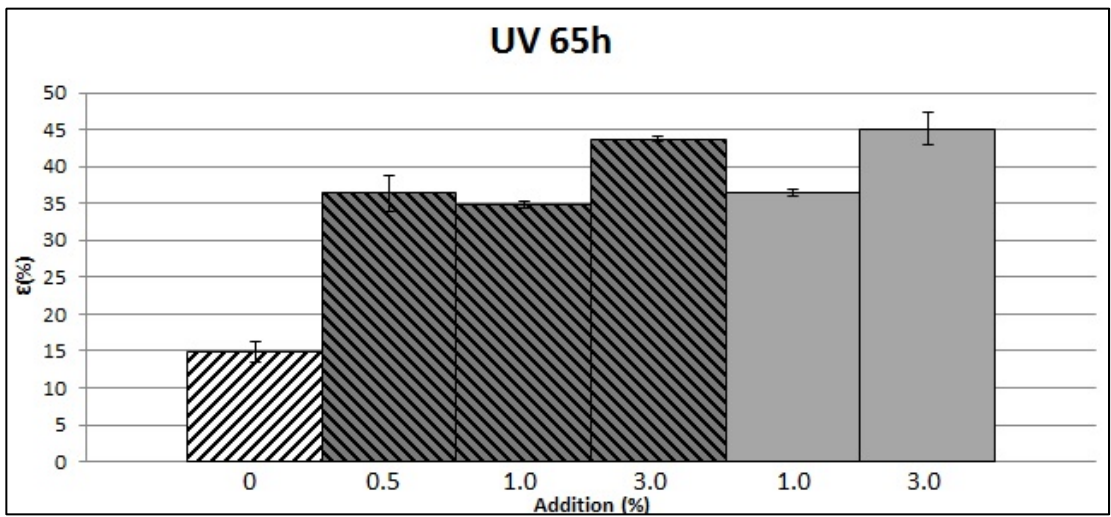
Figure 4. Photocatalytic efficiency Coefficient ( ε ) for samples in UV light with different addition percentages of TiO 2 − x N y and TiO 2 for samples at 65 h of curing age, control sample, TiO 2 − x N y , TiO 2 . Error bars are standard